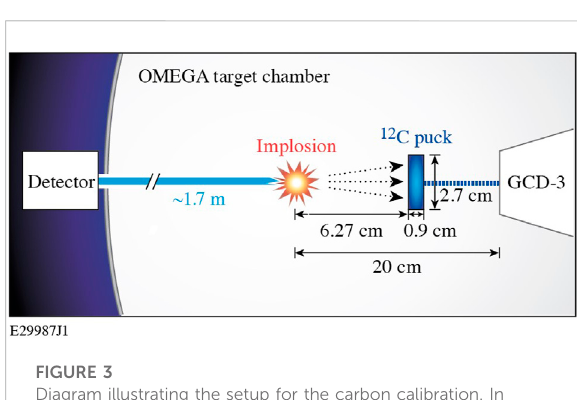
FIGURE 3 Diagram illustrating the setup for the carbon calibration.